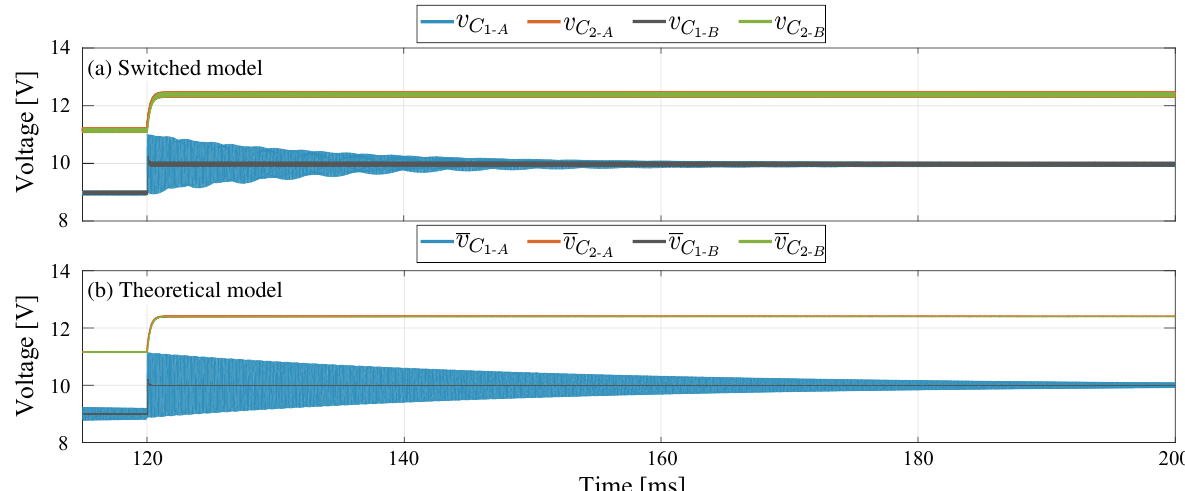
Figure 7. Comparison results for capacitor voltages in SEPIC converter with positive magnetic coupling, (A) without damping network, (B) with damping network: ( a ) switched model, ( b ) theoretical